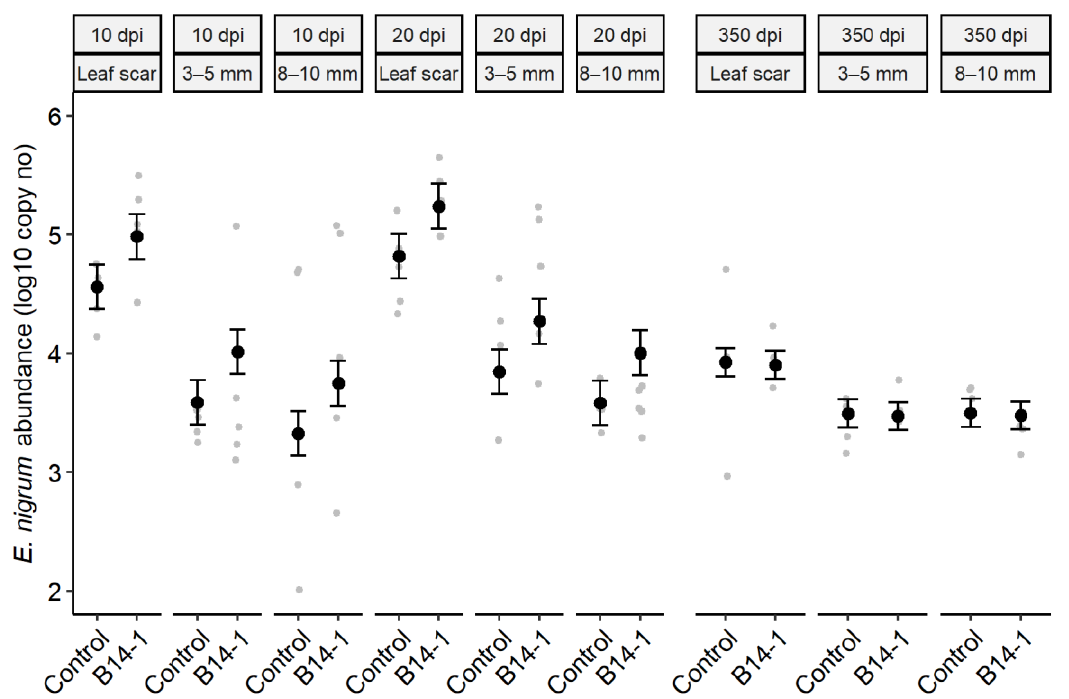
Figure 4. The abundance of E. nigrum DNA in shoots of cv. Royal Gala upon leaf scar inoculation. Estimated marginal means of abundance (total copy number per 1 µL extracted DNA) ± 1 SE in leaf scar tissue (“Leaf scar”), in bark wood 3–5 mm above and below (“3–5 mm”) and 8–10 mm above and below the leaf scar (“8–10 mm”), are shown at 10, 20 and 350 dpi. The treatments, presented on the horizontal axis, were: live B14-1 spores (B14-1), inactivated B14-1 spores (Control at 10, 20 dpi), or water (Control at 350 dpi). Raw data points for each time/tissue/treatment combination are shown in grey (10, 20 dpi n = 5; 350 dpi, n = 4). Each data point represents a pool of 12 leaf scars or bark and wood sections from three (10, 20 dpi) or four trees (350 dpi). The groups at 350 dpi are from a different experiment and are not directly comparable with 10 and 20 dpi.